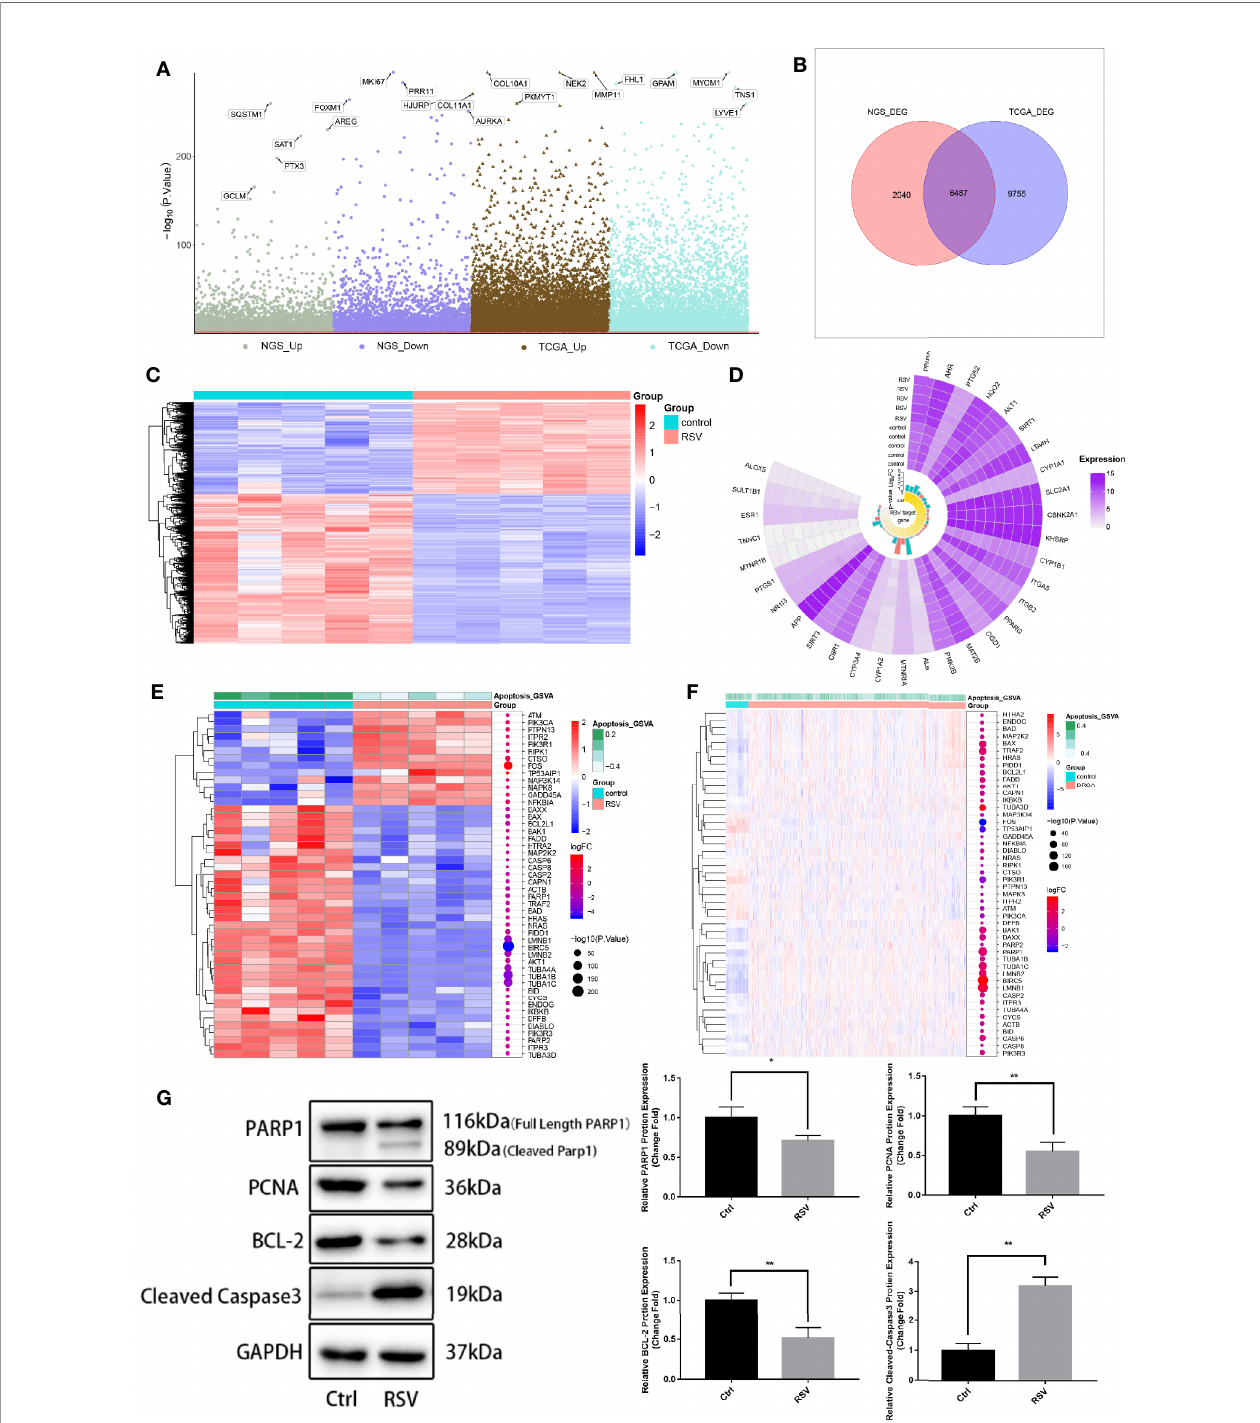
FIGURE 3 | Genes affecting resveratrol in the treatment of MDA-MB-231 cells. (A) Manhattan map. The differential expression analysis of the sequencing data of 50 m M resveratrol-treated MDA-MB-231 cell samples -control samples and the differential expression analysis of breast cancer samples - control samples of the TCGA database are respectively displayed. (B) Venn diagram. The intersection in the fi gure is the gene with the opposite differential expression, which is de fi ned as the gene affected by resveratrol in the treatment of breast cancer. (C) Expression heat map of genes affected by resveratrol in breast cancer treatment. (D) Circplot of resveratrol target in drugbank and resveratrol target domain protein in protein data bank (RNA sequencing data). (E) Apoptotic pathway-differential gene expression heat map (RNA sequencing data). (F) Apoptotic pathway-differential gene expression heat map (TCGA download breast cancer data). (G) Expression of apoptosis- related proteins in MDA-MB-231 cells after optimal resveratrol treatment (PARP1: * P =0.03, PCNA: ** P =0.008, BCL-2: ** P =0.006, Cleaved Caspased 3: ** P